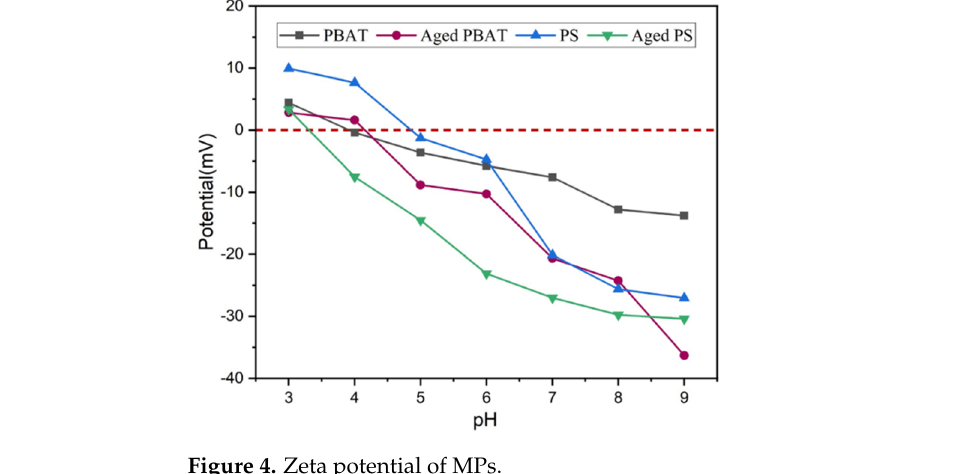
Figure 4. Zeta potential of MPs.